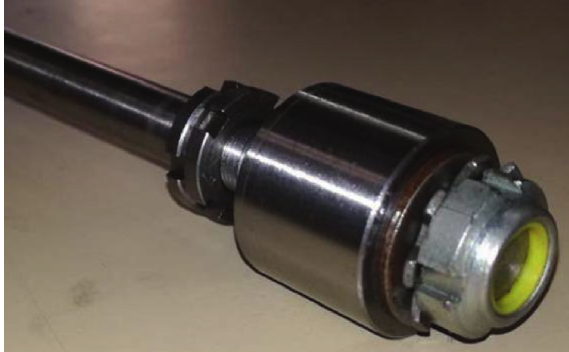
Figure 3: Prototype of the custom shaft with interchangeable journals.